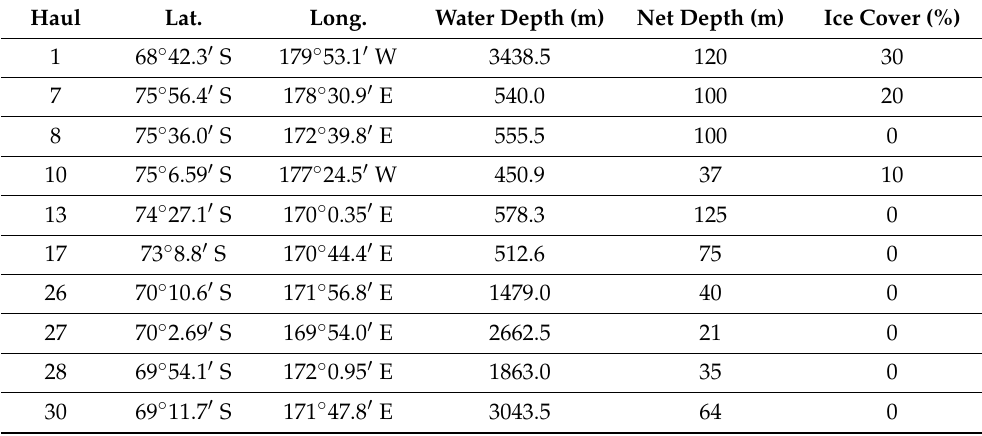
Figure 1. Krill sampling stations. Asterisks indicate the hauls that provided the specimens subjected to fatty acid analysis. Table 1. Geographical location of the hauls in western Ross Sea and the adjacent Pacific Ocean: latitude, longitude, water depth, maximum fishing net depth, and main environmental variables.